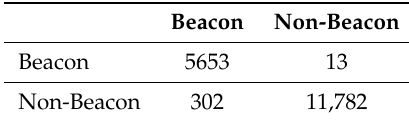
Table 3. LiDAR testing confusion